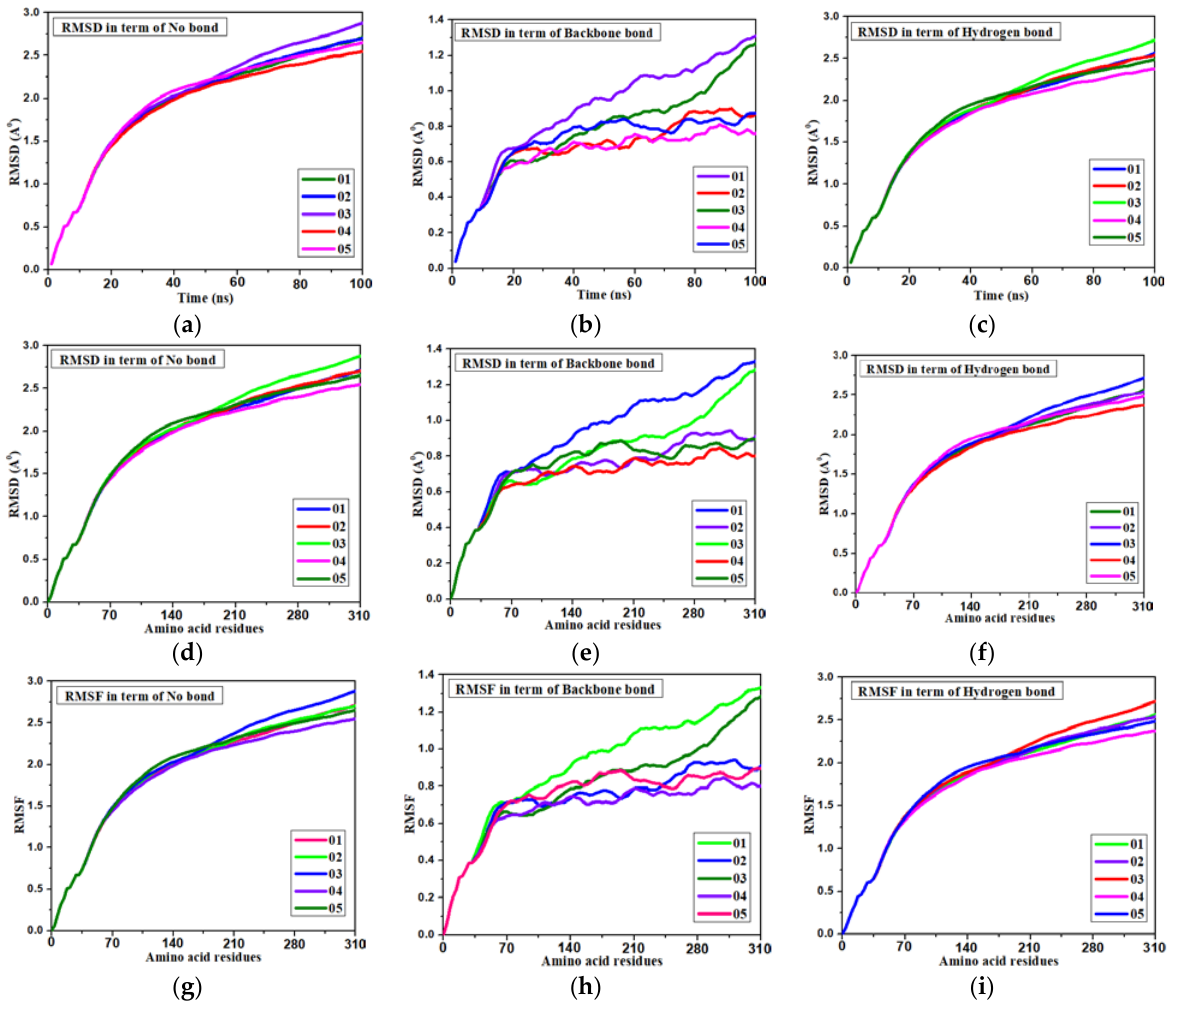
Figure 6. Various pictures of RMSD and RMSF for main protein (M pro ) of white spot disease. ( a ) RMSD: time vs no bond. ( b ) RMSD: time vs protein skeleton. ( c ) RMSD: time vs hydrogen bond. ( d ) RMSD: amino acid vs no bond. ( e ) RMSD: amino acid vs backbone. ( f ) RMSD: amino acid vs H bond. ( g ) RMSF: amino acid vs no bond. ( h ) RMSF: amino acid vs backbone. ( i ) RMSF: amino acid vs H bond. Table 9. Dose and performance of the